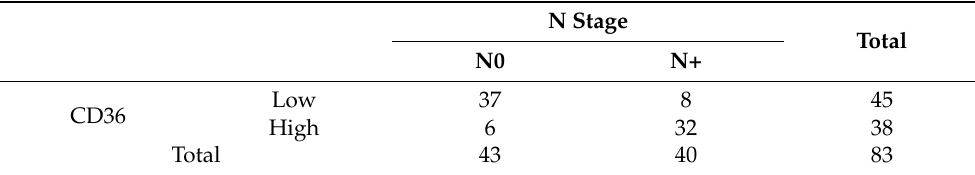
Table 4. Results of the logistic regression model. Characteristic OR 95% CI p -Value CD36